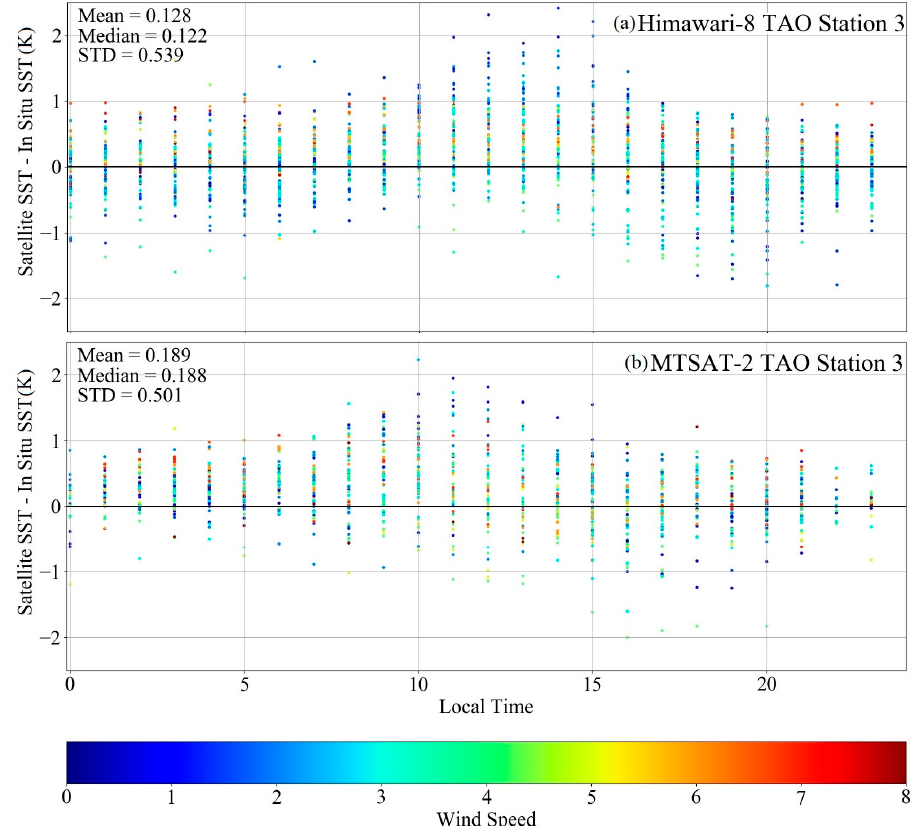
Figure 9. Differences between satellite-derived SST and in situ temperatures for each hour of the day at the TAO mooring 3 at 2°N, 137°E. The colors represent wind speed in ms − 1 . The dots correspond to highest quality data from 1 August 2015–31 October 2015. The top panel is for SSTs from Himawari-8 and the lower panel for SSTs from